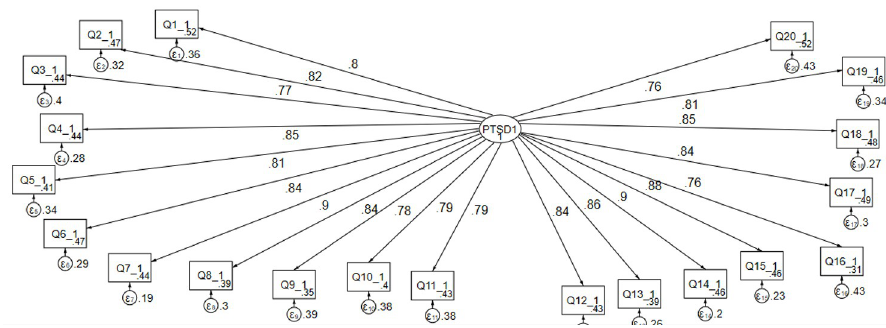
Fig 1. Results of a standardized factor loadings of a measurement model for PTSD symptoms (N = 775), Northwest, Ethiopia, 2021. Note: β ’s are standardized estimates, P-value < 0.001.